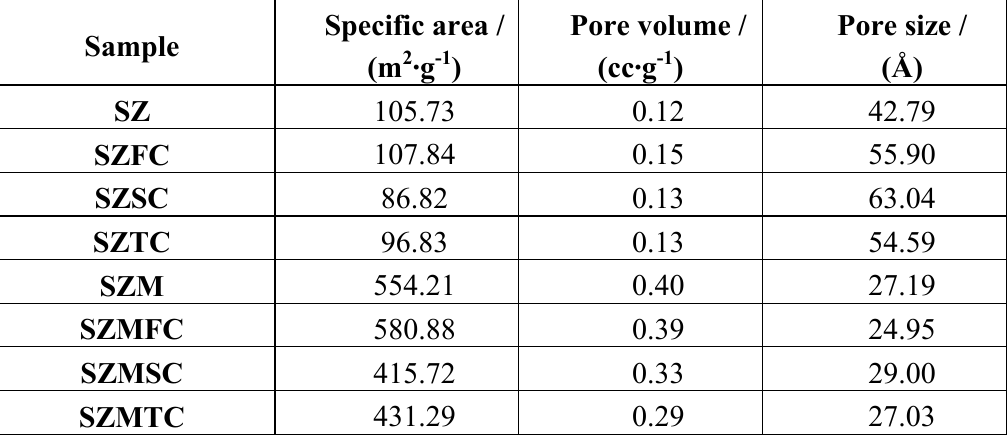
Table 1. Textural properties of the catalysts.